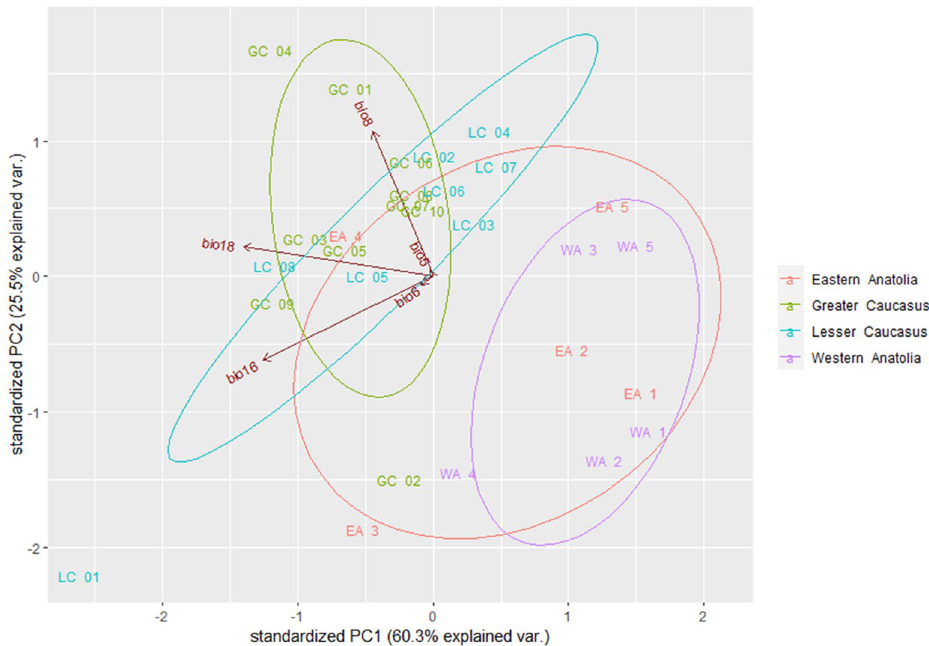
Figure 8. Principal component analysis (PCA) showing the climatic profiles of 28 studied populations of Scots pine based on the five bioclimatic variables that had the greatest impact on the distribution of the species in the Caucasus ecoregion ( bio5 —Max Temperature of Warmest Month, bio6 —Min Temperature of Coldest Month, bio8 —Mean Temperature of Wettest Quarter, bio16 —Precipitation of Wettest Quarter and bio18 —Precipitation of Warmest Quarter). The population acronyms are given in Table